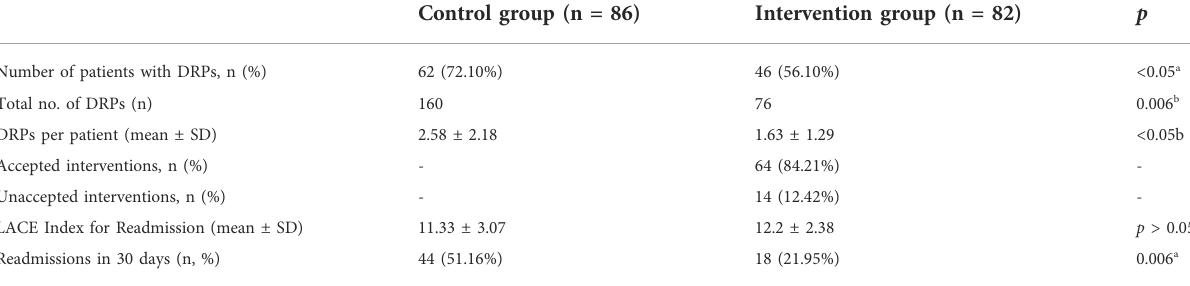
TABLE 3 Drug-related problems identi fi ed in the control and intervention groups.